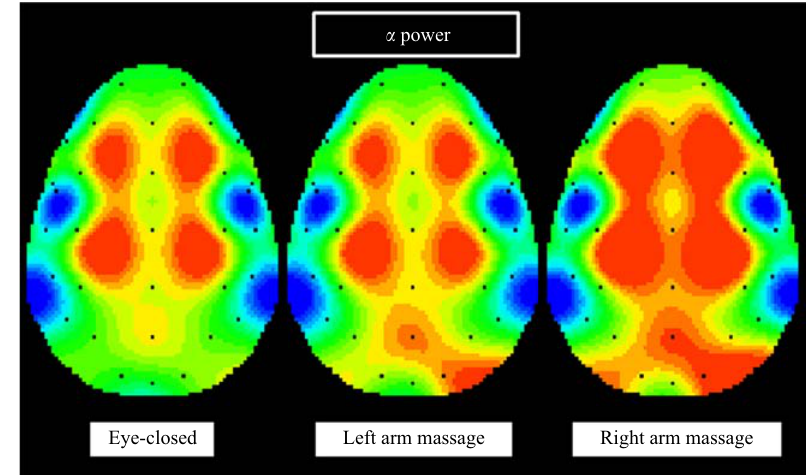
α power ( µ V 2 ) Massage conditions